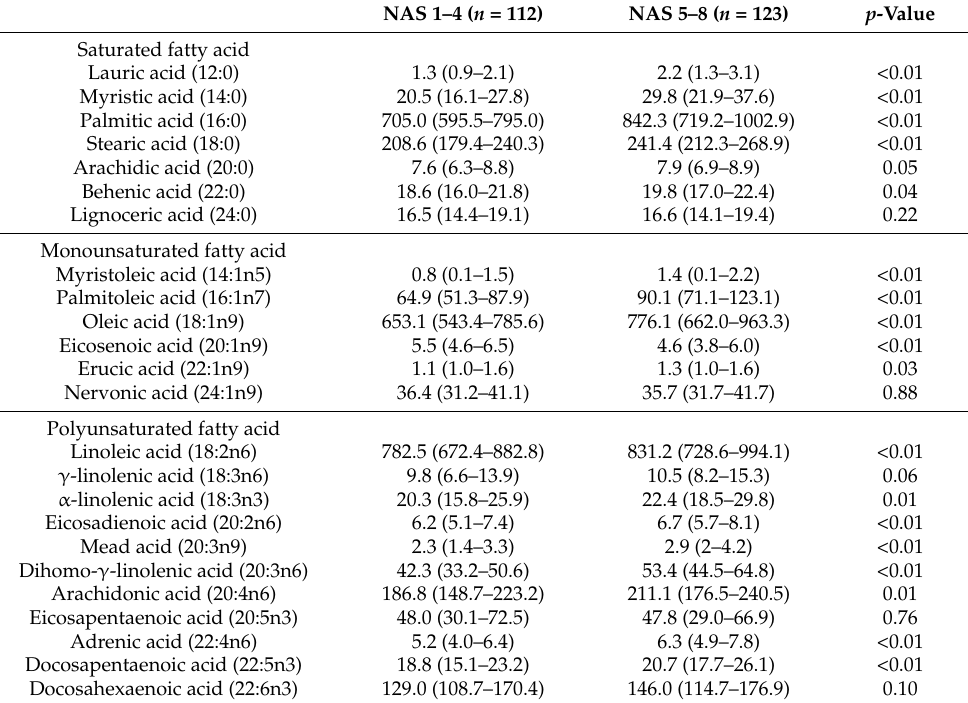
Table 6. Plasma fatty acid composition ( µ g/mL) (low NAS vs. high